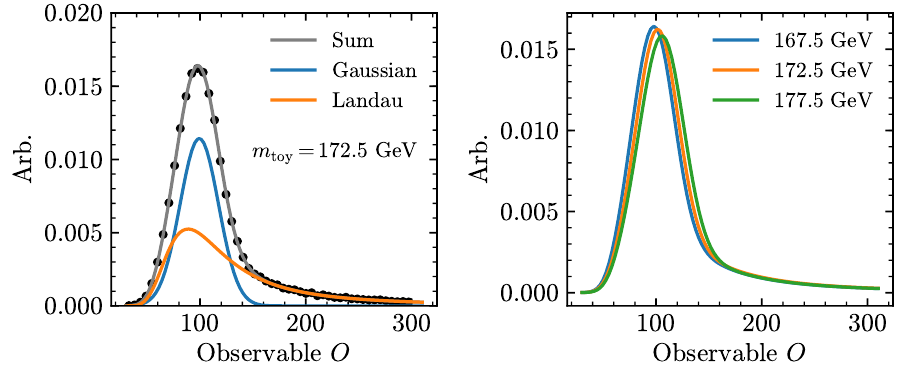
Figure 3 . Our toy observable is modeled with a probability distribution which is the sum of a Gaussian for the peak and a Landau function for the tail. The gray curve in the left panel shows the (cid:12)t to the black data points, while the blue and orange lines show the individual contributions of the Gaussian and Landau components, respectively. The right panel demonstrates how the shape of the observable changes as a function of m toy : the location of the peak of the observable O is highly correlated with m toy